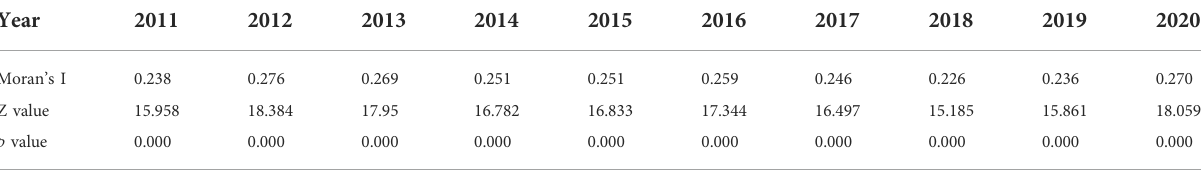
TABLE 5 Global Moran ’ s I index of high-quality economies of the three major urban agglomerations in the Yangtze River Economic Belt.